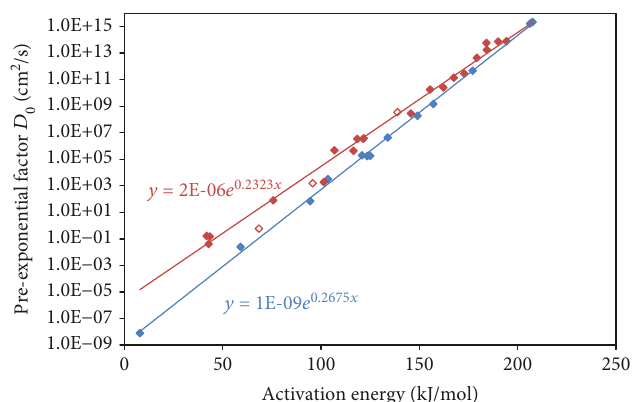
Figure 7: Correlation between the activation energy of di ff usion E (nonsolid red dots from Ref. [10]; solid red dots from Ref.